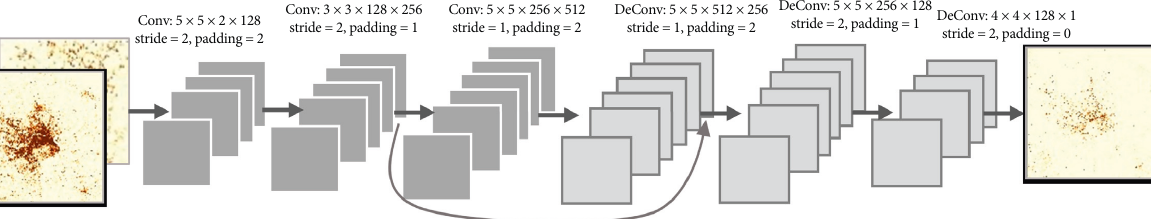
Figure 4: Proposed deep neural network